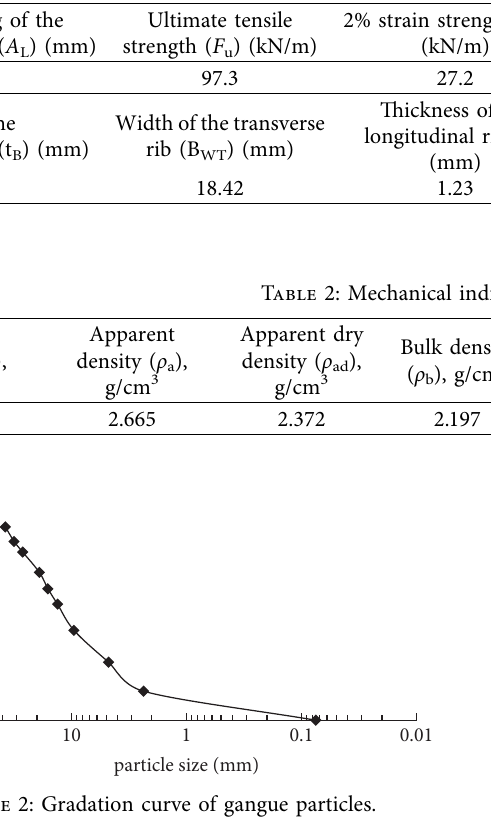
Figure 1: Uniaxial HDPE geogrid. (a) Object image. (b) Table 1: Technical indicators of the geogrid.